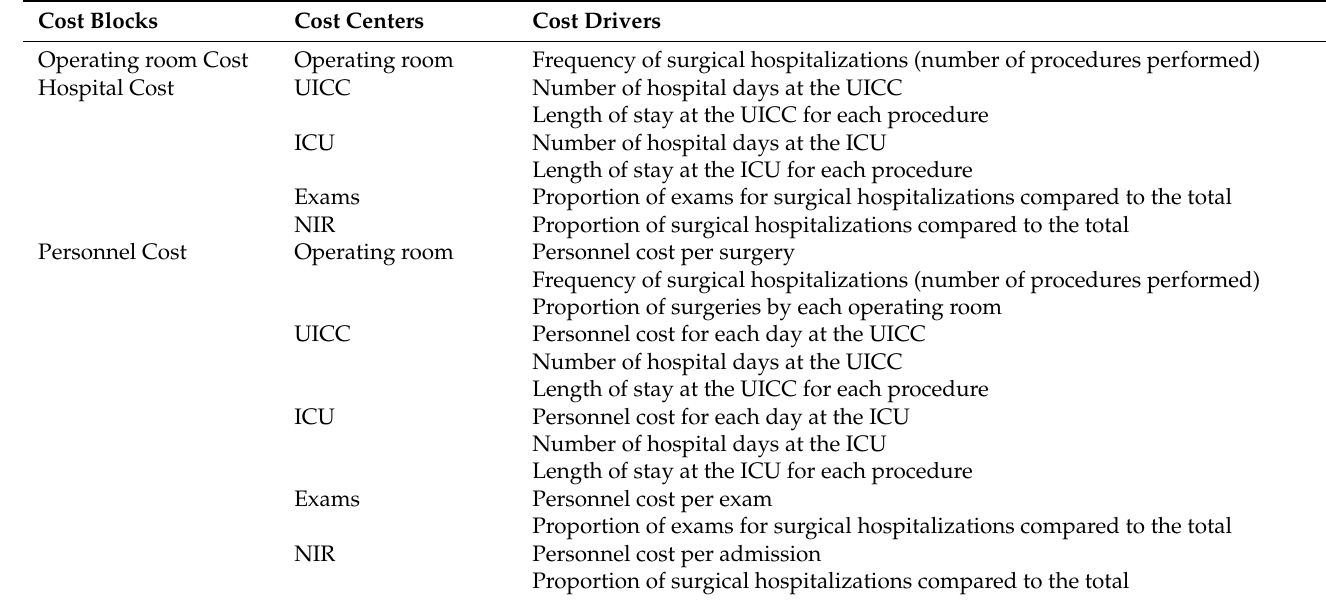
Table 5. Relationship between cost blocks, cost centers, and cost